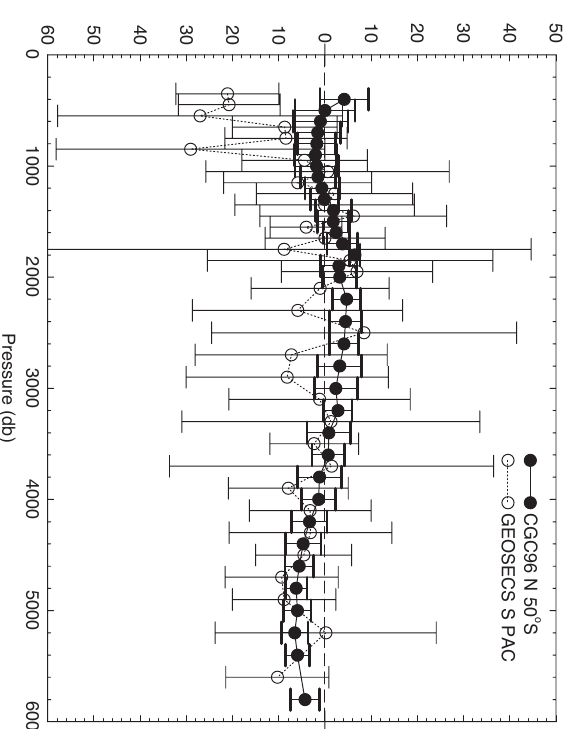
F IG . 5. – The distribution of residual DIC after all samples are binned into 100 m layer over the upper 2000 m depth and into 200 m layer below 2000 m depth. The solid cicles with heavy error bars are from CGC96, and open circles with lighter error bars are from GEOSECS in the South Pacific for stations north of 50°S between 120°W and 180°